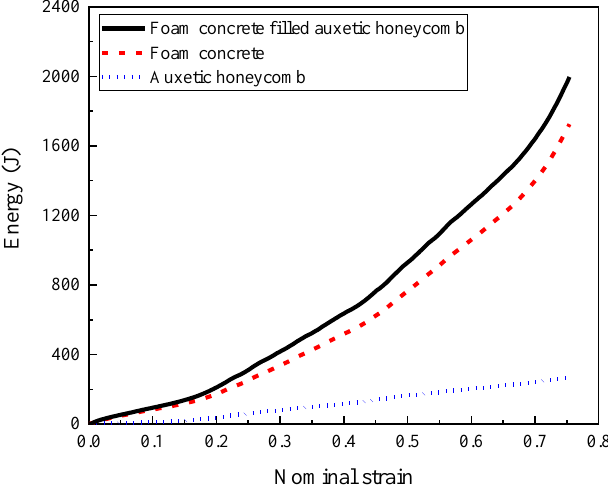
Figure 19. The energy absorption performance of the auxetic honeycomb, foam concrete, and com- posite ( t = 0.2:0.2:0.2 and ρ = 408:575:848, 1 m/s).